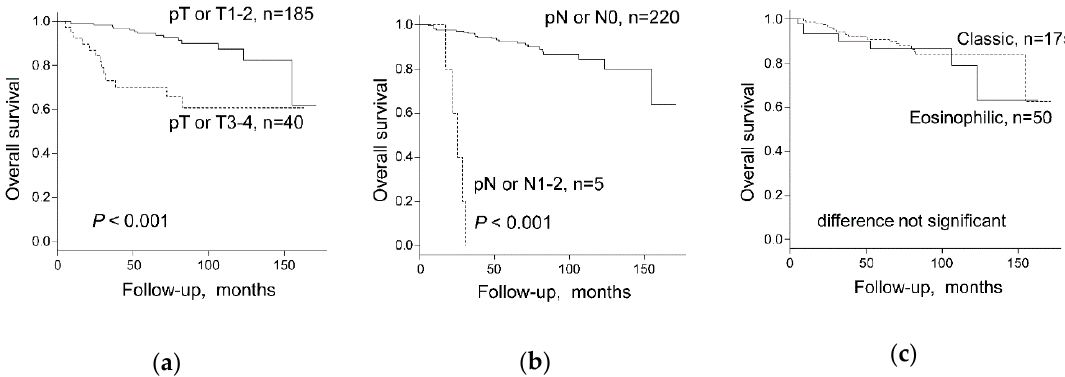
Figure 4. Overall survival stratified by ( a ) pT Stage or T stage (1–2 versus 3–4), ( b ) pN stage or N stage (pN1–2 versus pN0), and ( c ) chromophobe renal cell carcinoma (chRCC) subtype in all 225 chRCC patients combined from the Swiss, the Cancer Genome Atlas Kidney Chromophobe (TCGA-KICH), and Japanese cohorts. pT Stage or T stage: Swiss and Japanese cohorts, pT stage, and TCGA-KICH, T stage was used for the calculation. pN stage or N stage: Swiss and Japanese cohorts, pN stage, and TCGA-KICH, N stage was used for the